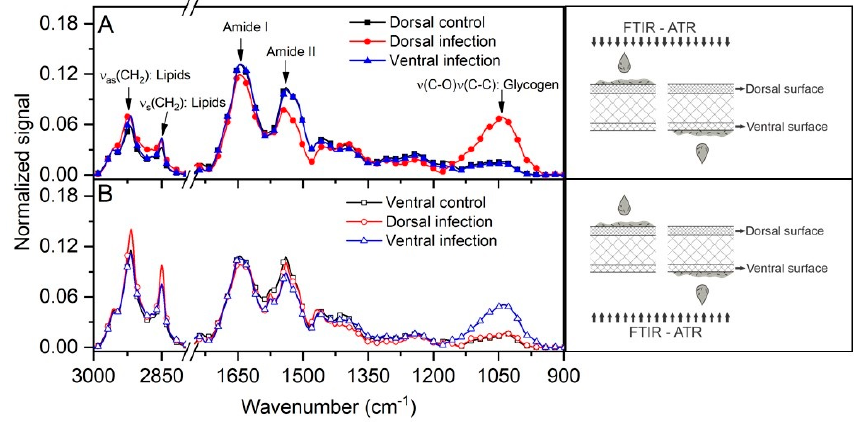
Figure 3. FTIR-ATR spectra analysis of the growth of C. albicans inoculated on both nail surfaces with readings obtained from the dorsal ( A ) and ventral ( B ) sides. Of note is the intensity of the peak at ~1050 cm − 1 , which was more intense on the side where the inoculation occurred. Readings were made according to the illustrative scheme presented on the right side of each graph.